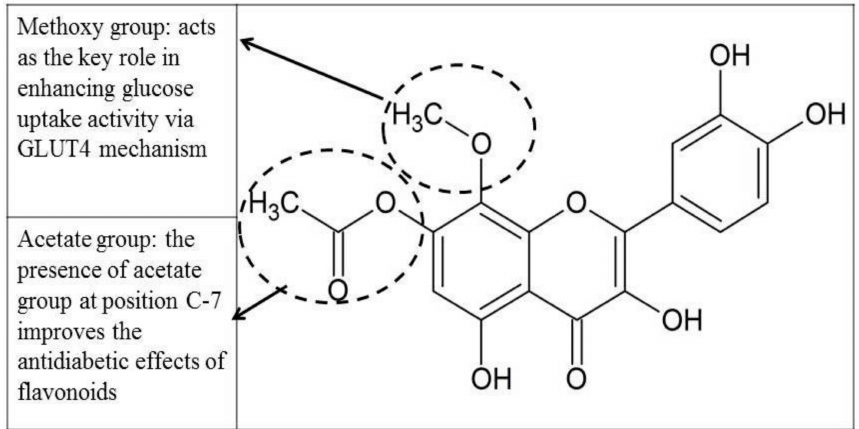
Figure 16. Methyl and acetate groups act as the key role in the antidiabetic activity for the glucose uptake